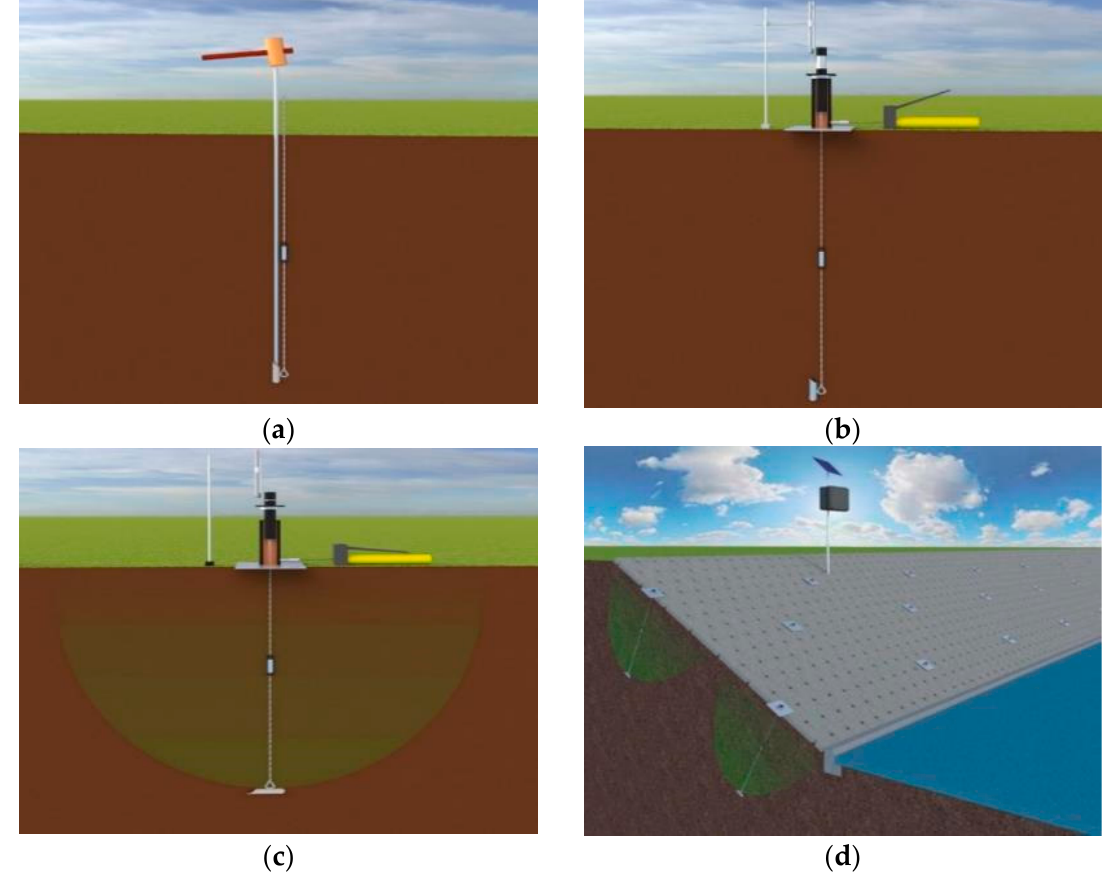
Figure 11. Illustration of PDEA anchoring and testing process: ( a ) anchor driven, ( b ) pullout test setup, ( c ) pullout test (anchor rotation), and ( d ) anchor locking and finish surface of slope.